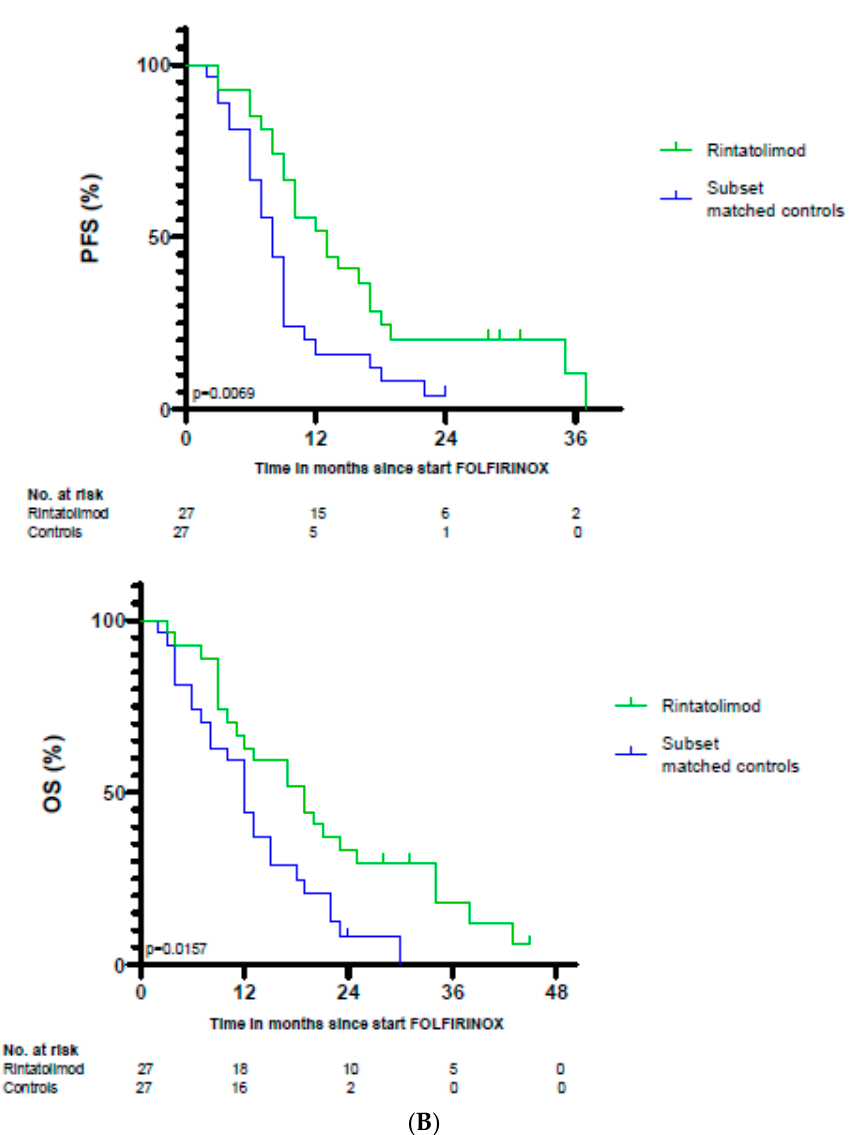
Figure 5. ( A ) Kaplan–Meier estimates for progression-free survival and overall survival of patients with locally advanced and metastatic pancreatic cancer treated with rintatolimod ( n = 27) compared to matched controls ( n = 54). ( B ) Kaplan–Meier estimates for progression-free survival and overall survival of patients with locally advanced and metastatic pancreatic cancer treated with rintatolimod (n = 27) compared to subset of matched controls ( n = 27). p -values are from the Cox proportional hazards model.